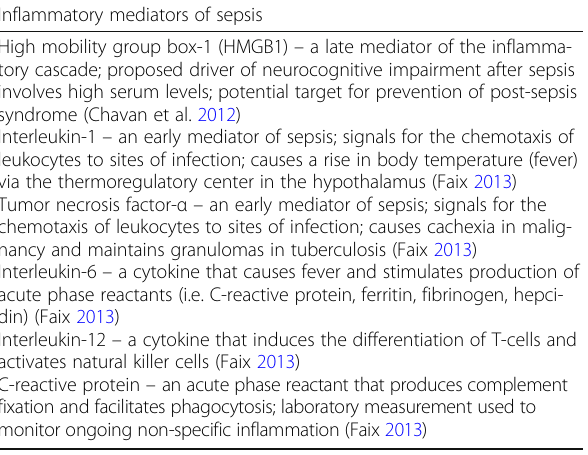
Table 1 Inflammatory mediators of sepsis Inflammatory mediators of